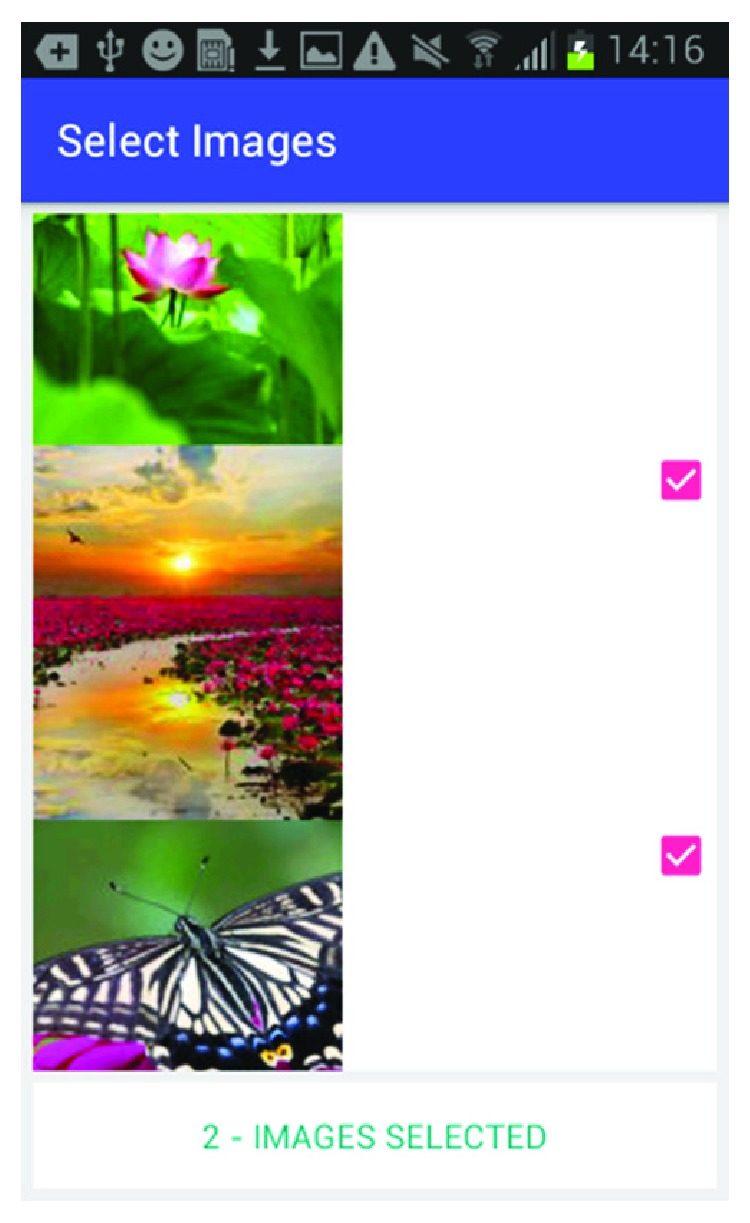
Photo selection.